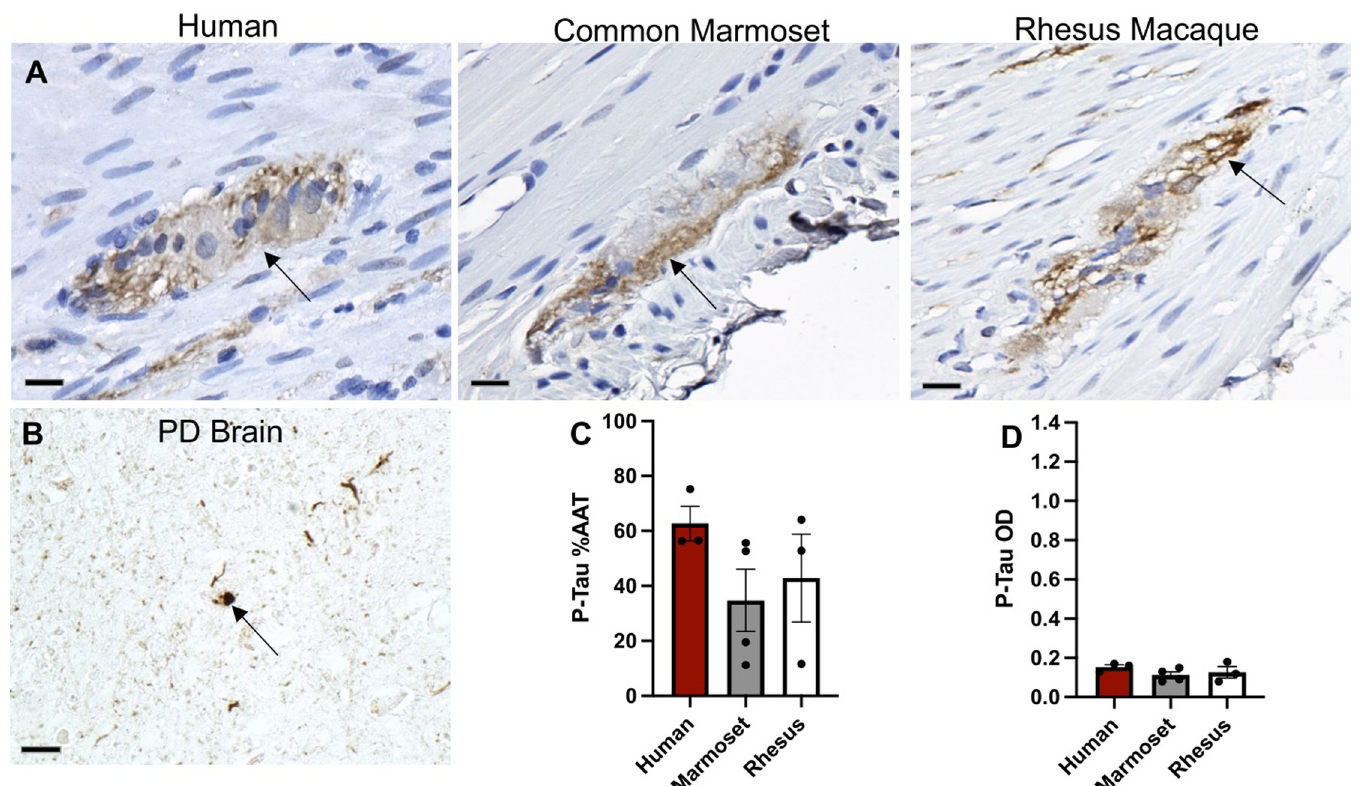
Fig 5. P-tau expression in the appendix/cecum across species. (A) Images of p-tau-immunoreactivity (-ir) (brown) in the myenteric ganglia (arrows) in human appendix, common marmoset and rhesus macaque ceca tissue sections counterstained with hematoxylin (blue). (B) Image of p-tau-ir in a Lewy body from